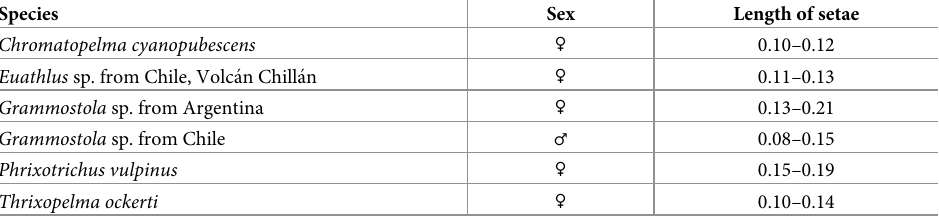
Table 11. Length ranges of type IV setae.